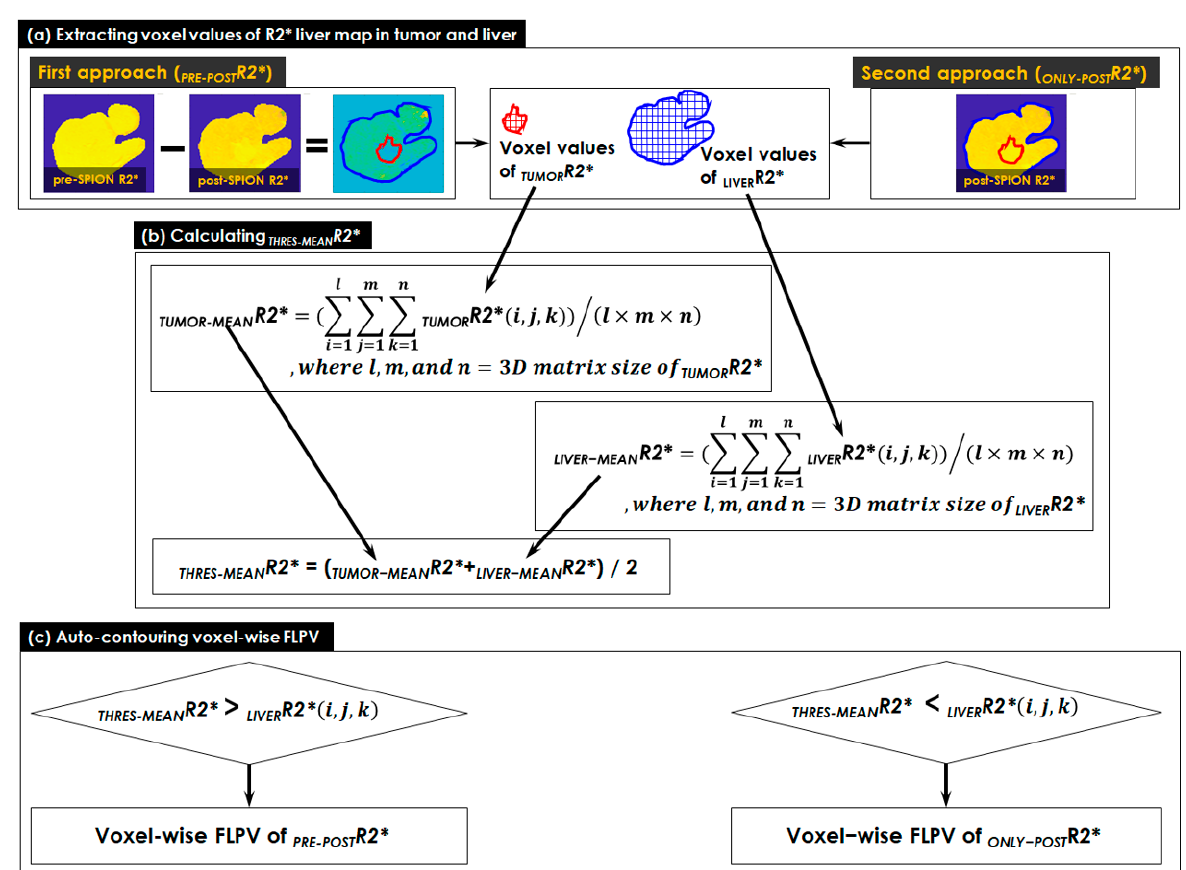
Figure 2. The two approaches for auto-contouring voxel-wise FLPV. ( a ) Extracting voxel values of R2* liver map in tumor and liver contours, which used both pre- and post-SPION R2* liver maps in the first approach ( PRE-POST R2* ) and only a single post-SPION R2* liver map in the second approach ( ONLY-POST R2* ); ( b ) calculating a threshold ( THRES-MEAN R2* ) using the middle value of TUMOR-MEAN R2* (an average of all voxel values in TUMOR R2* ) and LIVER-MEAN R2* (an average of all voxel values in LIVER R2* ); and ( c ) auto-contouring voxel-wise FLPV determined by comparing each voxel value of R2* liver map to THRES-MEAN R2* . If each voxel was greater than THRES-MEAN R2* , it became a voxel of FLPV in the PRE-POST R2* approach, but the opposite worked in the ONLY-POST R2* approach. FLPV was saved as a new contour together with the physician-identified tumor and liver contours and transferred to MiM for further overlaying on the liver image.